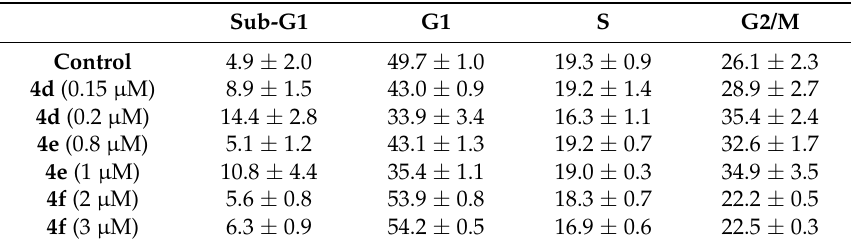
Table 3. Effect of 4d–4f on the cell cycle of 518A2 melanoma cells 1 .